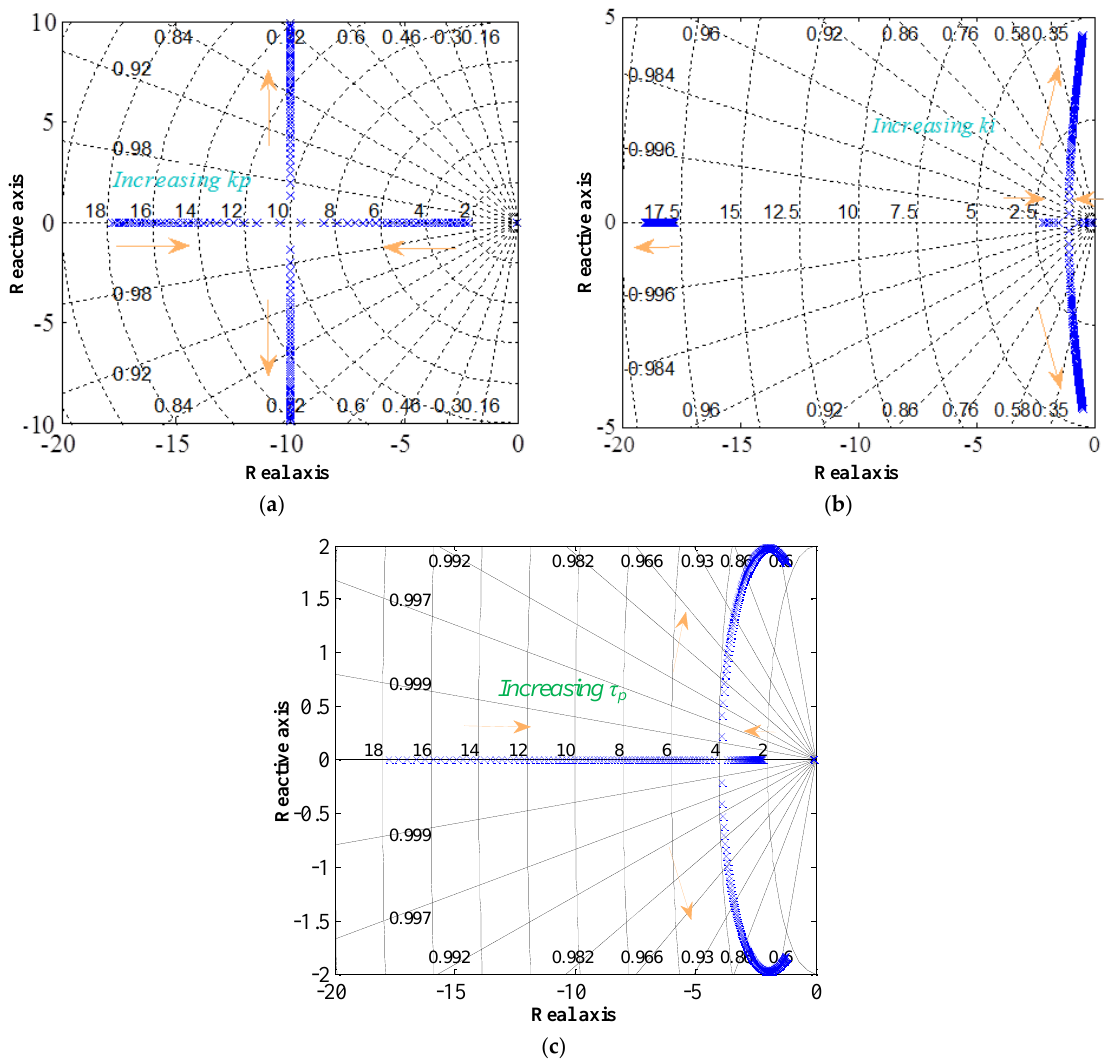
Figure 5. Root-locus under different control parameters: ( a ) trace of modes as a function of proportional term of excitation system regulator: 0.0000001 < k p < 0.008; ( b ) trace of modes as a function of proportional term of excitation system regulator: 0.0001 < k i < 0.02) and ( c ) trace of modes as a function of proportional term of excitation system regulator: 0.05 < τ p < 0.5.